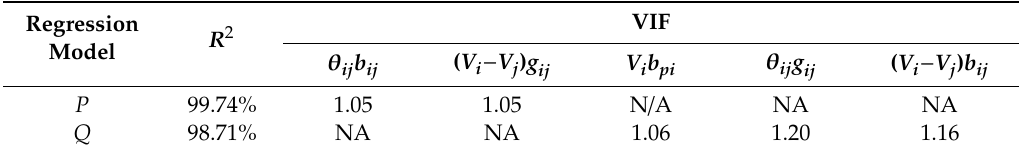
Table 4. Results of Regression Analysis.